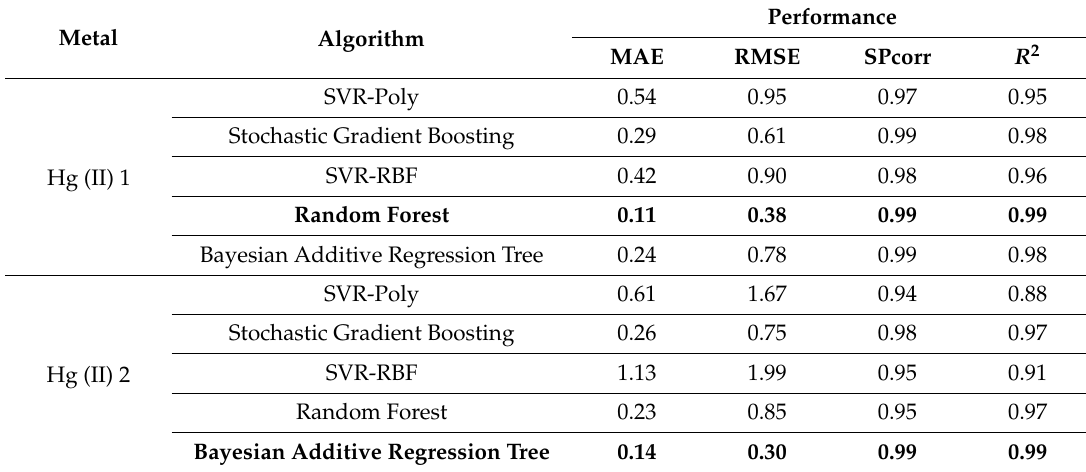
Table 8. The performances of five (5) MLA models on independent test data (20%) of Hg(II) datasets. Metal